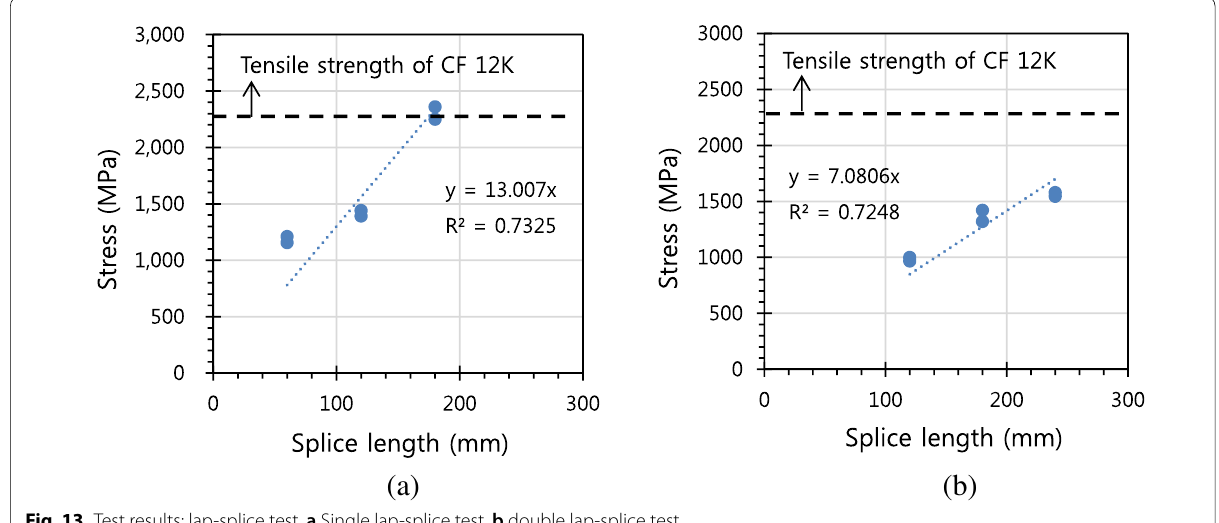
Fig. 13 Test results: lap-splice test. a Single lap-splice test, b double lap-splice test.